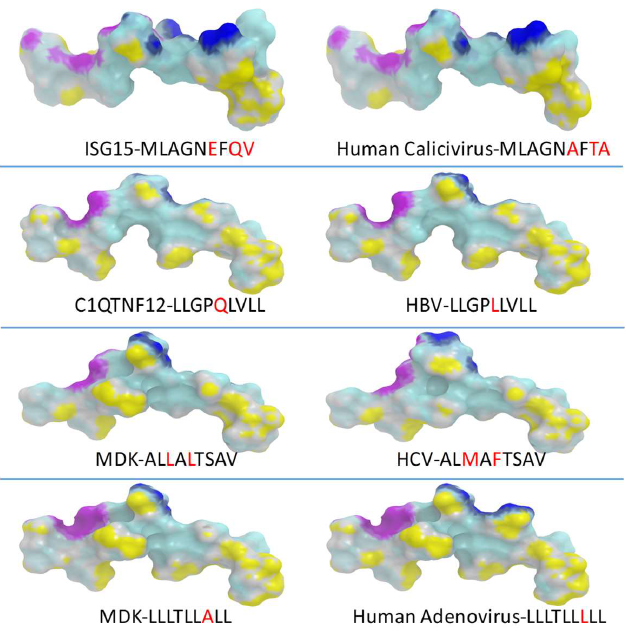
Figure 5. Predicted 3D conformation of paired peptides. The conformation of the TAA peptides and paired viral antigens bound to the HLA-A*02:01 molecule is shown. The prediction was performed using as template structure the HTLV-I LLFGYPVYV peptide crystallized with the HLA-A*0201 molecule, the β2 microglobulin, the α and β chains of the T-cell receptor (TCR) (PDB https://www.rcsb.org/structure/1AO7 (accessed on 14 April 2021)). Yellow areas = contact points with HLA molecule; blue areas = contact points with the TCR α chain; violet areas = contact points with the TCR β chain.